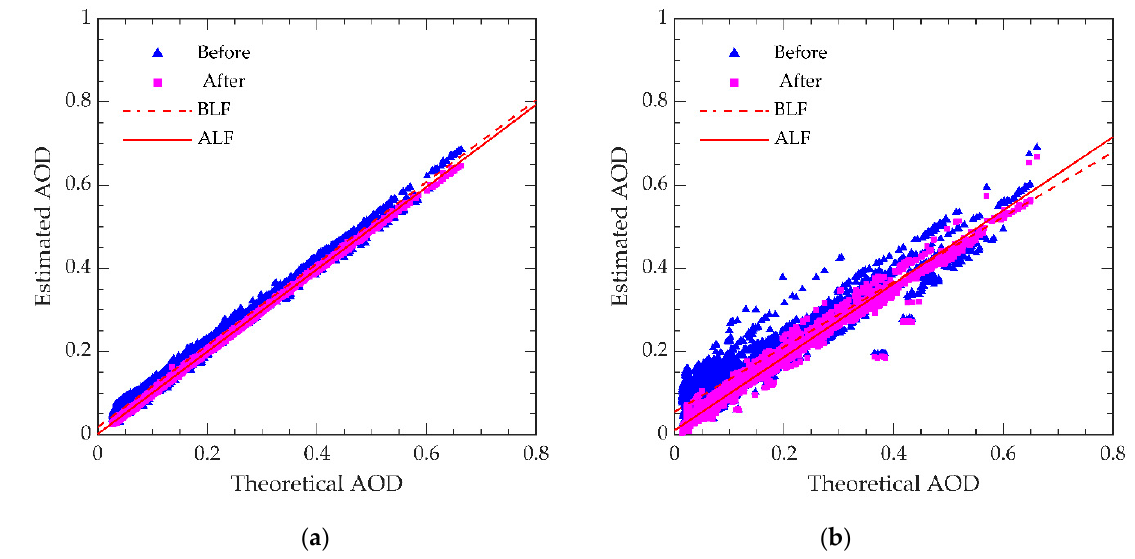
Figure 5. The estimated AOD before and after calibration changing with the theoretical AOD. There are 8969 points: ( a )1020 nm; ( b ) 1639 nm.